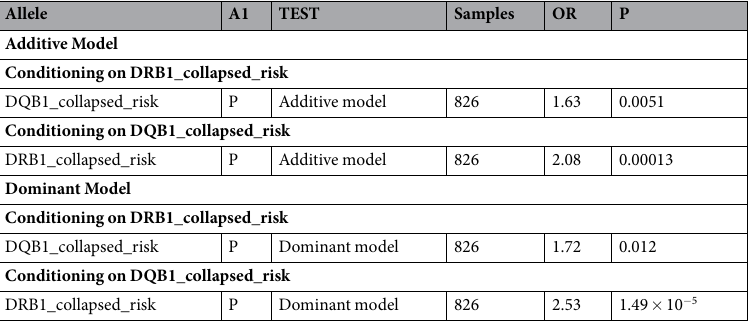
Table 6. Reciprocal conditional tests on HLA-DRB1 and HLA-DQB1 collapsed risk alleles in additive and dominant models. (222 IMN vs. 701